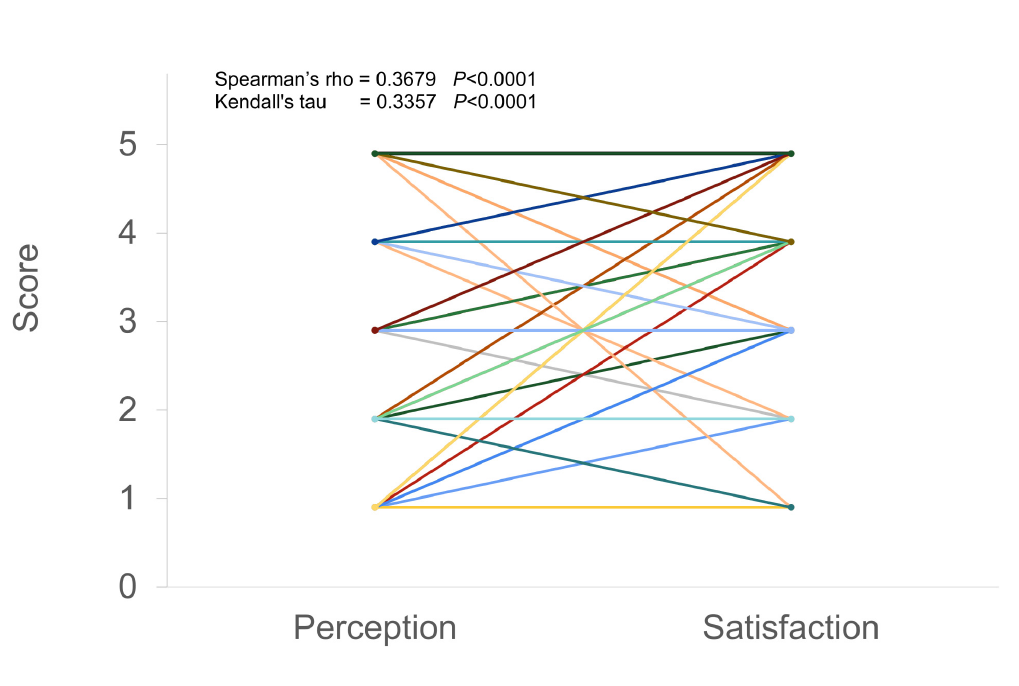
Fig 3. Correlation between “Perception” and “Satisfaction”. Spearman’s rank-order correlation coefficient ρ (rho) was used as a nonparametric measure of the strength of the association between the two variables. Kendall’s rank correlation coefficient τ (tau) was calculated to confirm the ordinal association between the variables. Both coefficients were statistically significant ( p < 0.0001).